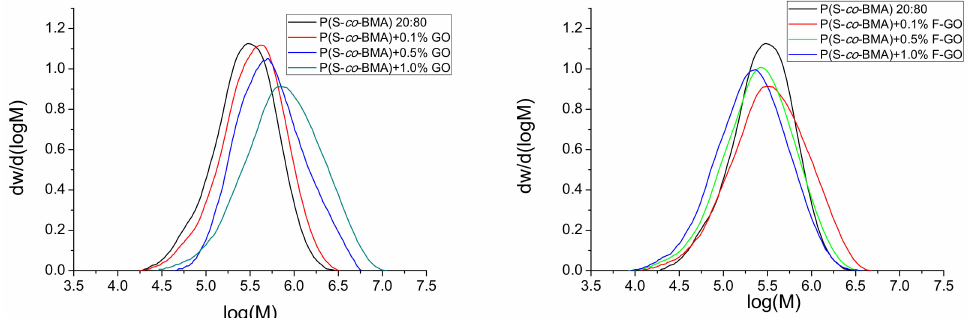
Figure 4. Molecular weight distribution of neat P(S- co -BMA) 20:80 and its nanocomposites with either GO ( a ) or F-GO ( b ) obtained after bulk in-situ radical polymerization.